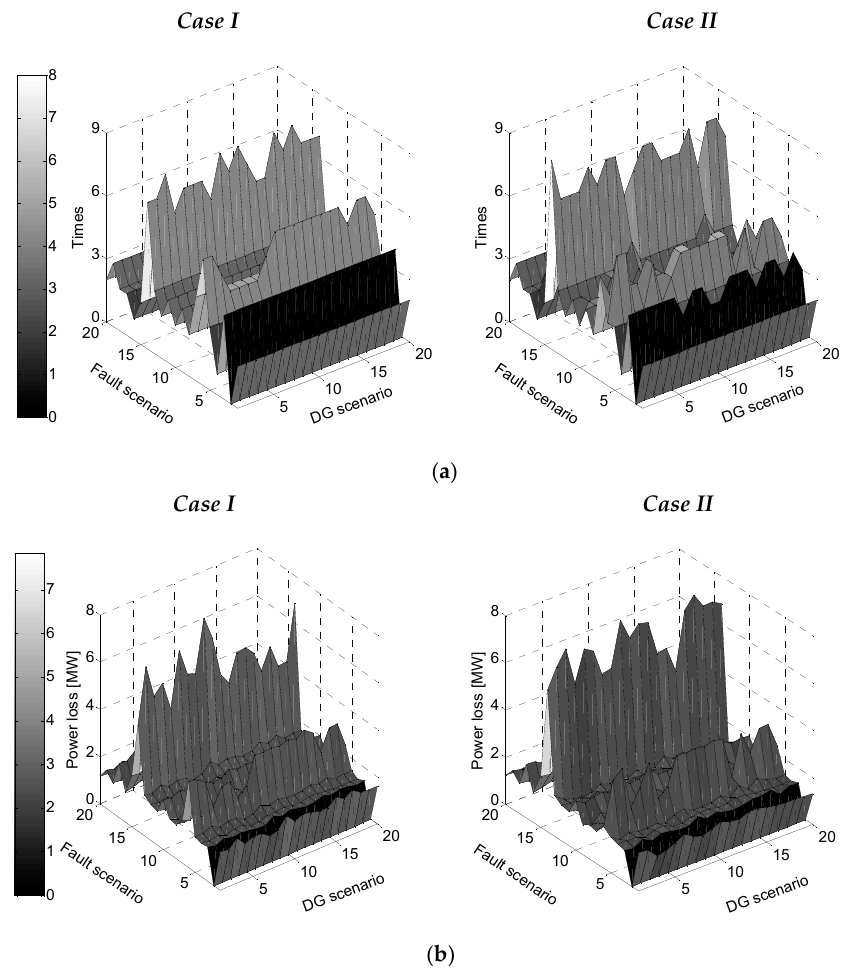
Figure 8. Performance of load restoration for case I and case II (our solution) ( a ) switcher operation times; and ( b ) power loss.